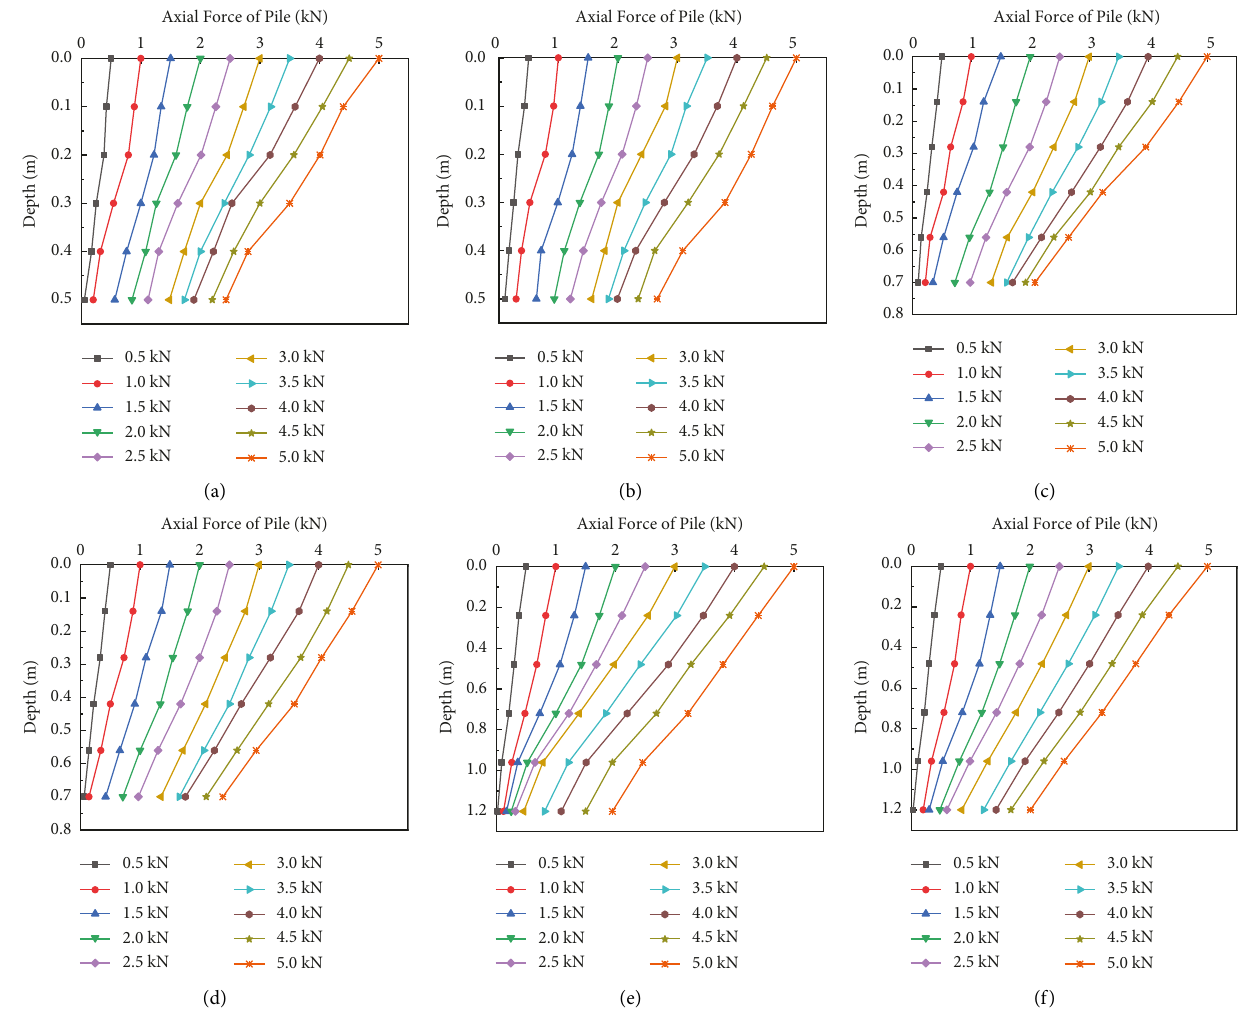
Figure 8: Axial force curves of model piles. (a) M0. (b) M1. (c) M2. (d) M3. (e) M4. (f)